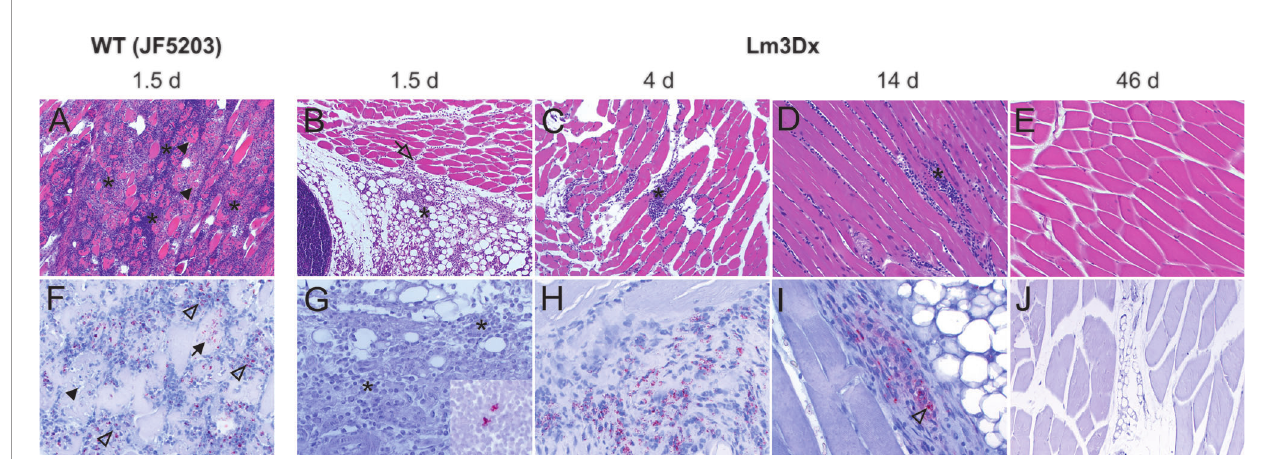
FIGURE 7 | Representative HE (A – E) and immunohistochemically (with antibody against Lm) (F – J) stained muscle tissue of representative WT- and Lm3Dx_SAG1- injected mice. (A) Severe necrosuppurative myositis with marked neutrophilic in fi ltration (asterisks) and multifocal severe myo fi ber necrosis (arrowheads) is present in the thigh musculature of WT injected mice at 1.5d after inoculation (100x magni fi cation). (B) Focal-extensive and prominent in fi ltration of the intermuscular fat tissue with neutrophils and macrophages (asterisk) that extends into the muscular interstitium (open arrow) in a mice at 1.5d following injection with 1 x 10 7 Lm3Dx_SAG1 (100x). No myo fi ber necrosis is present. (C) Focal in fi ltrate with moderate numbers of neutrophils and macrophages (asterisk) that is restricted to the interstitial space between muscle fi bers of the thigh musculature in a lactating mouse at 4d following inoculation with Lm3Dx_SAG1 (100x magni fi cation). No myo fi ber necrosis is present. (D) Mild lymphohistiocytic in fi ltrates (asterisk) are present between muscle fi bers of the thigh musculature of mice at 14d following the last boost with Lm3Dx_SAG1 (200x magni fi cation). No myo fi ber necrosis is present. (E) At 46 days following the second boost with Lm3Dx_SAG1, the thigh muscle is free of in fl ammatory in fi ltrates (200x magni fi cation). (F) Myriads of bacteria are observed in myo fi bers (arrow) and within neutrophils (open arrowheads) at 1.5d following inoculation with WT (200x magni fi cation). Arrowhead indicates necrotic myo fi ber. (G) At day 1.5 following inoculation of adult mice, no bacteria are observed in the interstitial in fi ltrate (asterisks, 400x magni fi cation). One/5 mice had a positive signal in the popliteal lymph node (inset, 400x magni fi cation). (H) At day 4 following inoculation of lactating mice with Lm3Dx_SAG1, interstitial in fi ltrates contain moderate numbers of bacteria (400x magni fi cation). Neighboring myo fi bers are normal. (I) Few in fl ammatory cells within the interstitial in fi ltrates contain bacteria (open arrowhead) or bacterial fragments at 14 days following the second boost with Lm3Dx_SAG1 (400x magni fi cation). (J) No bacteria are present in the thigh muscle of LM3Dx_SAG1 injected mice at 46 days following the second boost (200x magni fi